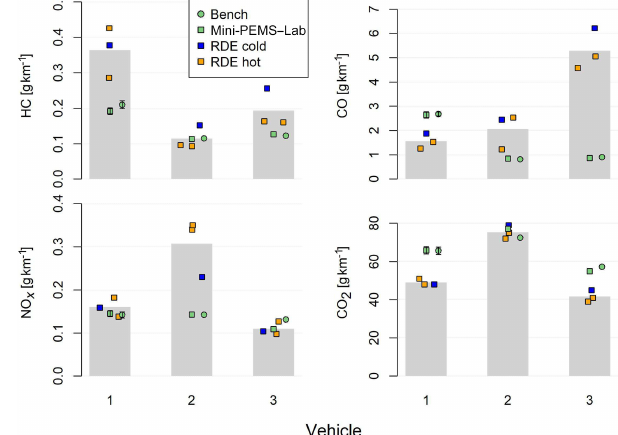
Figure 7. Summary of real-driving and laboratory emission factors. Roller bench emissions were obtained with laboratory instrumenta- tion (green circles) and the Mini-PEMS (green squares). Grey bars are average real-driving emission factors obtained with the Mini- PEMS from on-road cold-start (blue squares) and hot-start tests (or- ange squares). Error bars appear only on the first column in order to preserve